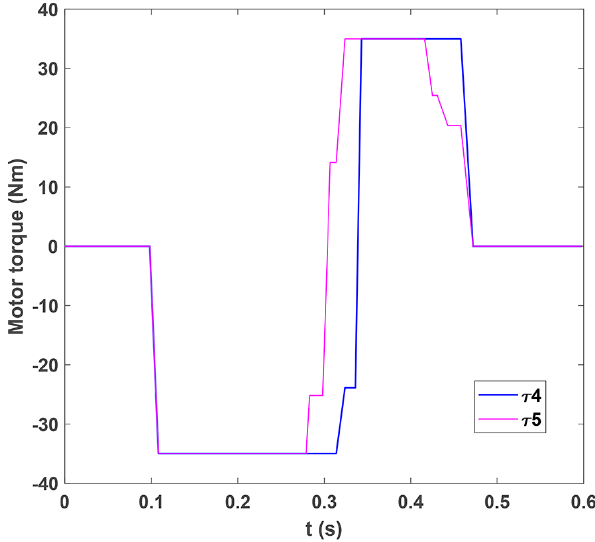
Figure 5. The motor torque of the brachiation